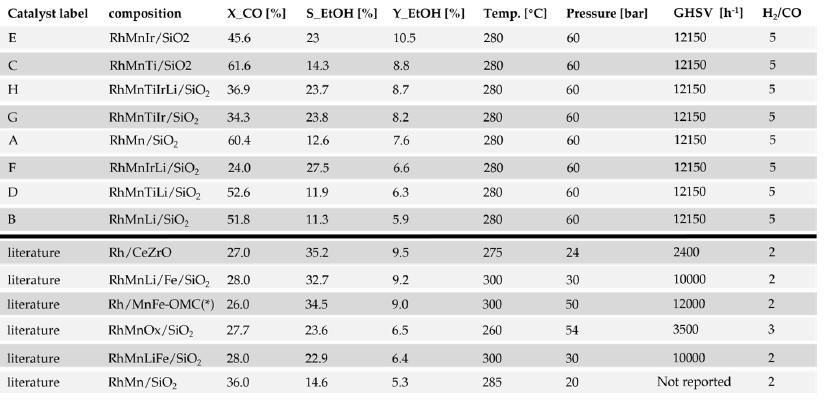
Figure 11. Performance details for eight studied catalysts of the current study and highest ethanol yielding catalysts from literature. The performance for catalysts of current study (labels A–H) is obtained at Exp 4 (T = 280 °C, P = 60 bar, total flow = 51 mL/min, H2:CO = 75:15 %V). (*) OMC: Ordered Mesoporous Carbon.